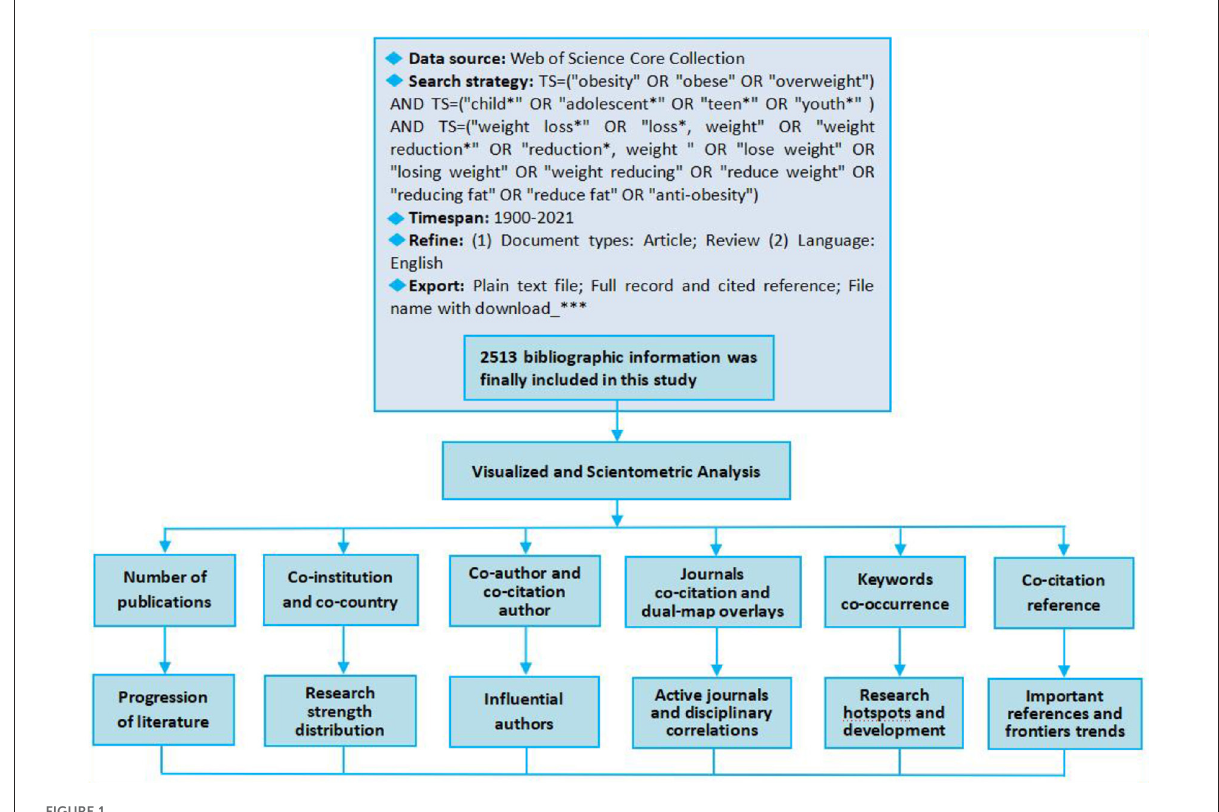
FIGURE1 Design of the